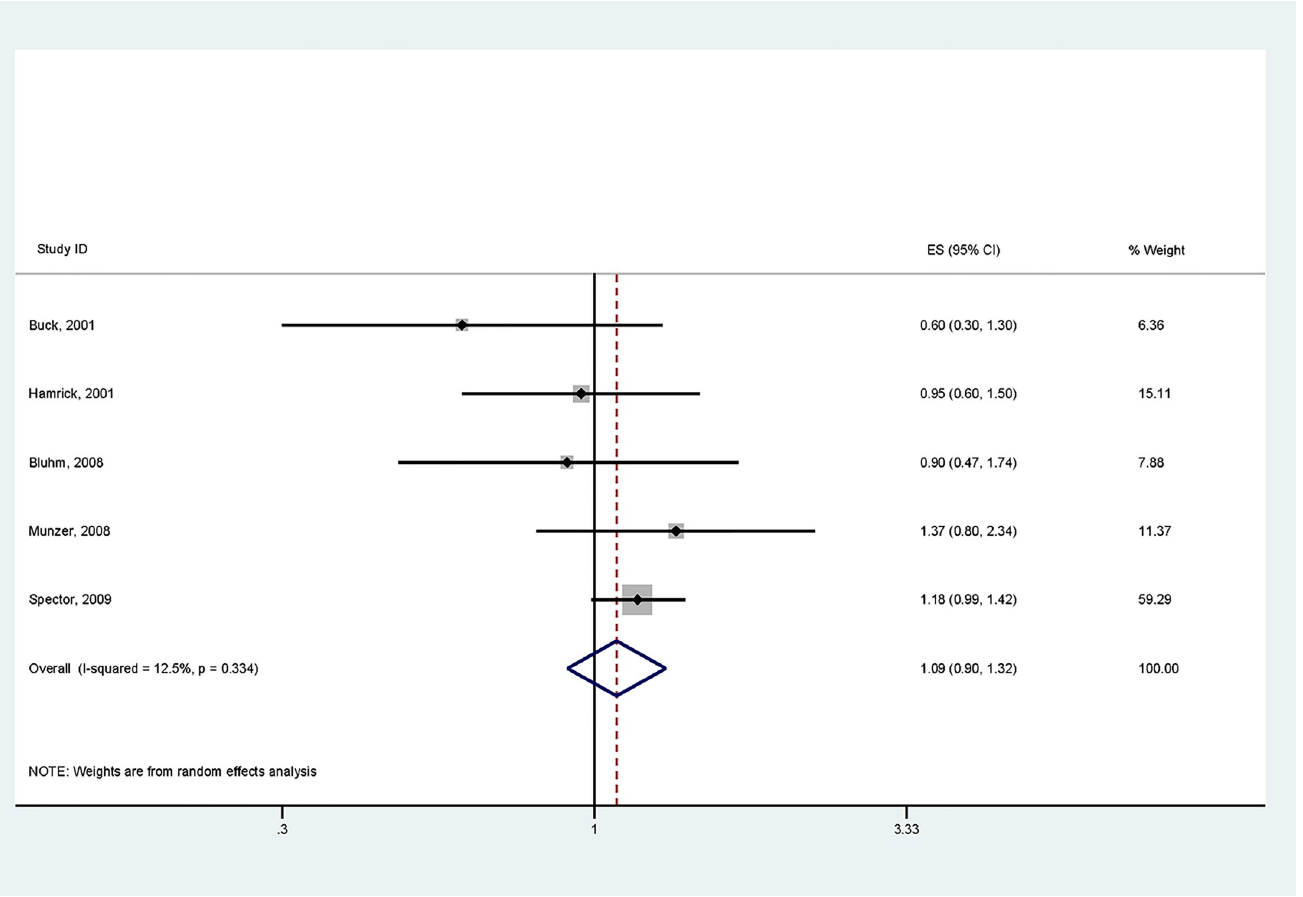
Fig 3. Forest plot of GA < vs � 37 weeks and the risk of developing neuroblastoma.